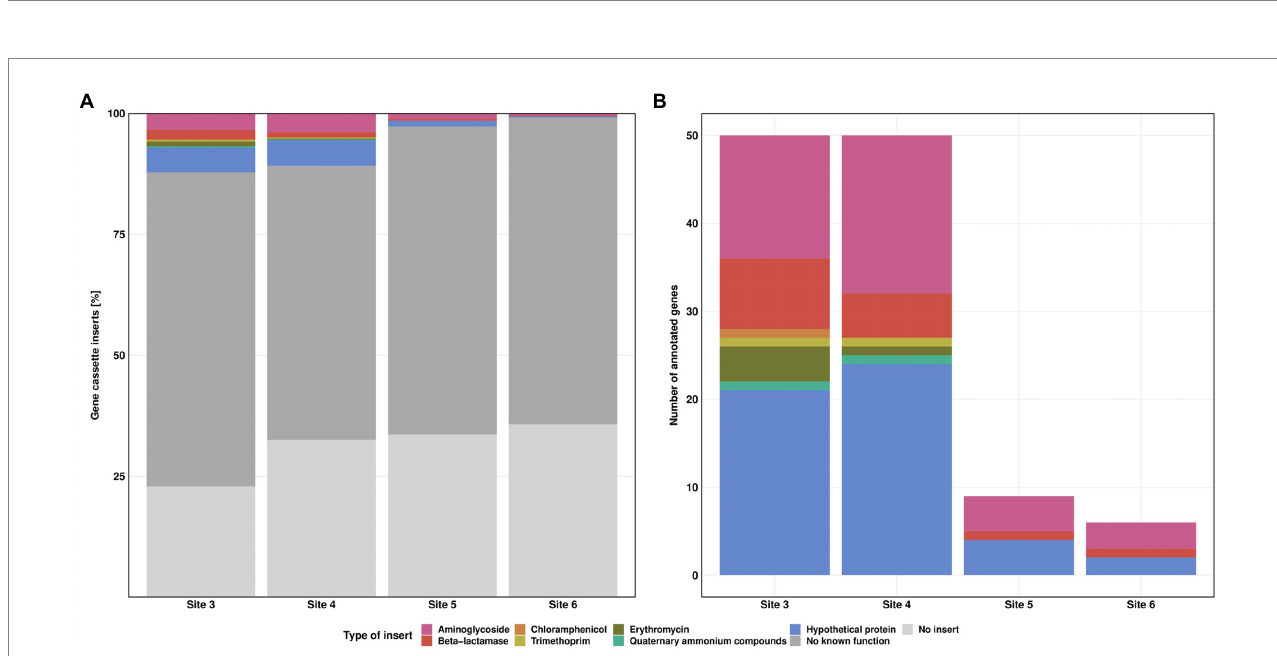
FIGURE 6 Class 1 integron gene cassette inserts. Relative frequency of insert types for each Site (A) . Absolute counts of annotated gene cassette inserts for each Site (B) . Resistance against streptomycin (pink), beta-lactamase (red), chloramphenicol (orange), trimethoprim (yellow), erythromycin (green) and quaternary ammonium compounds (turquoise). “No known function” (dark grey) refers to reads without known annotation in GenBank database. “No insert” (light grey) refers to reads where 5’CS and 3’CS were directly linked, without a variable region in between.